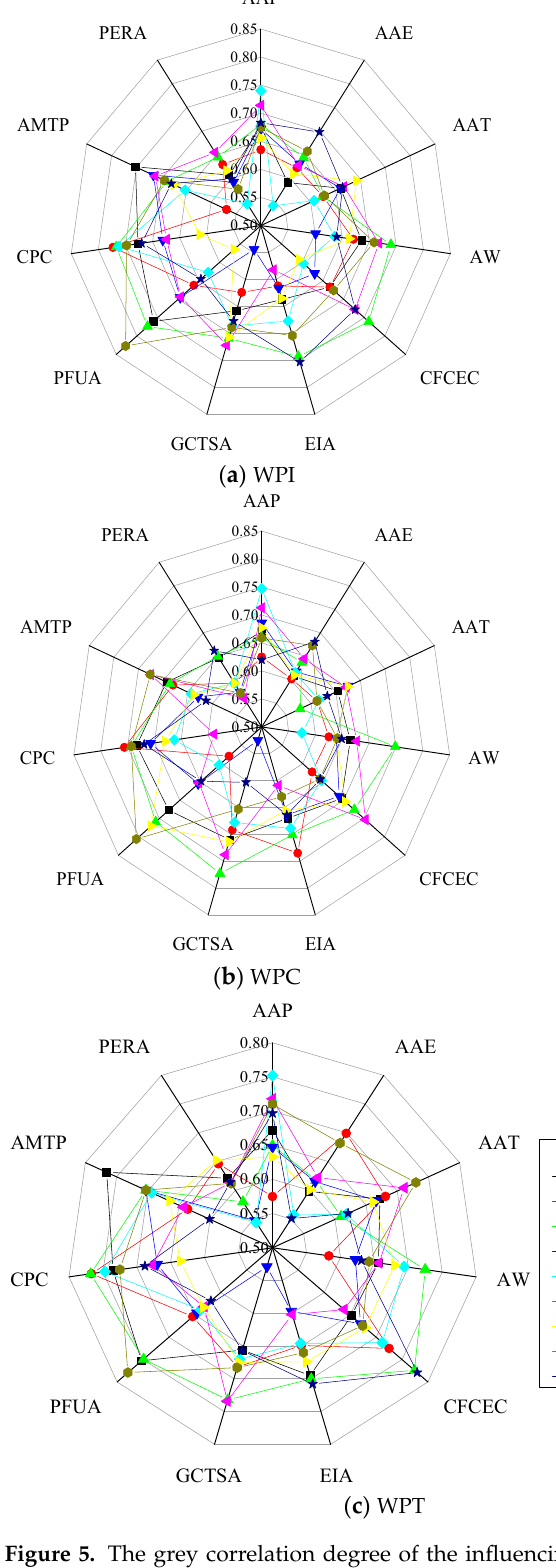
Figure 5. The grey correlation degree of the influencing factors with regard to water productiv- ity. ( a ) Grey correlation degree of the influencing factors to WPI of the provinces (autonomous regions). ( b ) Grey correlation degree of the influencing factors with regard to WPC of the provinces (autonomous regions). ( c ) Grey correlation degree of the influencing factors with regard to WPT of the provinces (autonomous